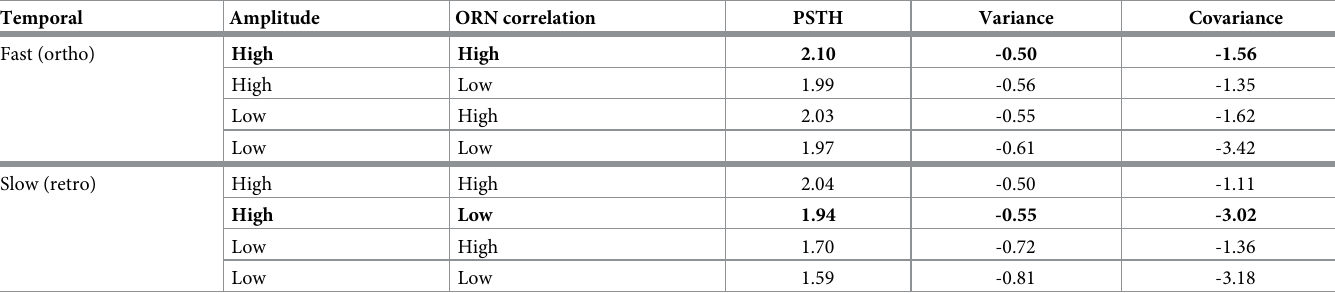
The parameter b for the LN model fits (Eq (1)) of the various parameters for temporal profile, amplitude, and input correlation. Amplitude and ORN input correlation profiles as defined for Figs 3–5 and associated values previously listed in Table 1 are noted in